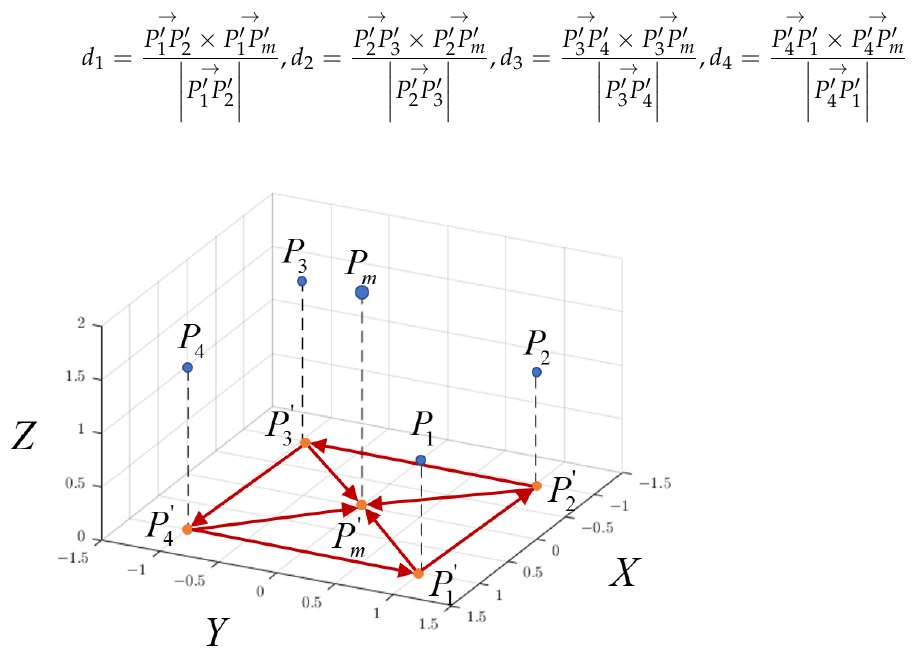
Figure 8. The projections of feature points in the world frame.